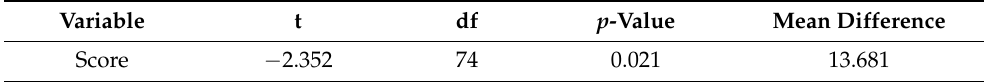
Table 7. Results of the t -test for equality of means. (Students’ scores in the midterm exam).